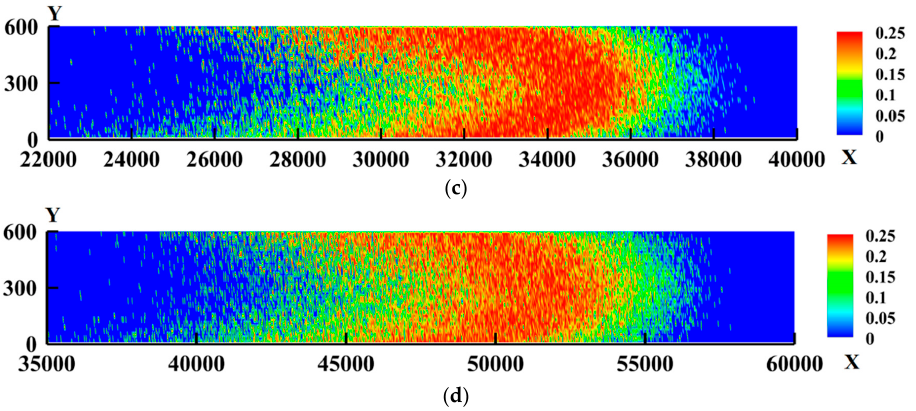
Figure 6. Mixing efficiency in the flow channel based on the contours of the mixing quality index, ϕ , for two puffs, puff A: Sc = 0.7, y o = 300, and puff B: Sc = 0.7, y o = 15. ( a ) Contours of ϕ at t = 500; ( b ) at t = 1000; ( c ) at t = 2000; and ( d ) at t = 3000.